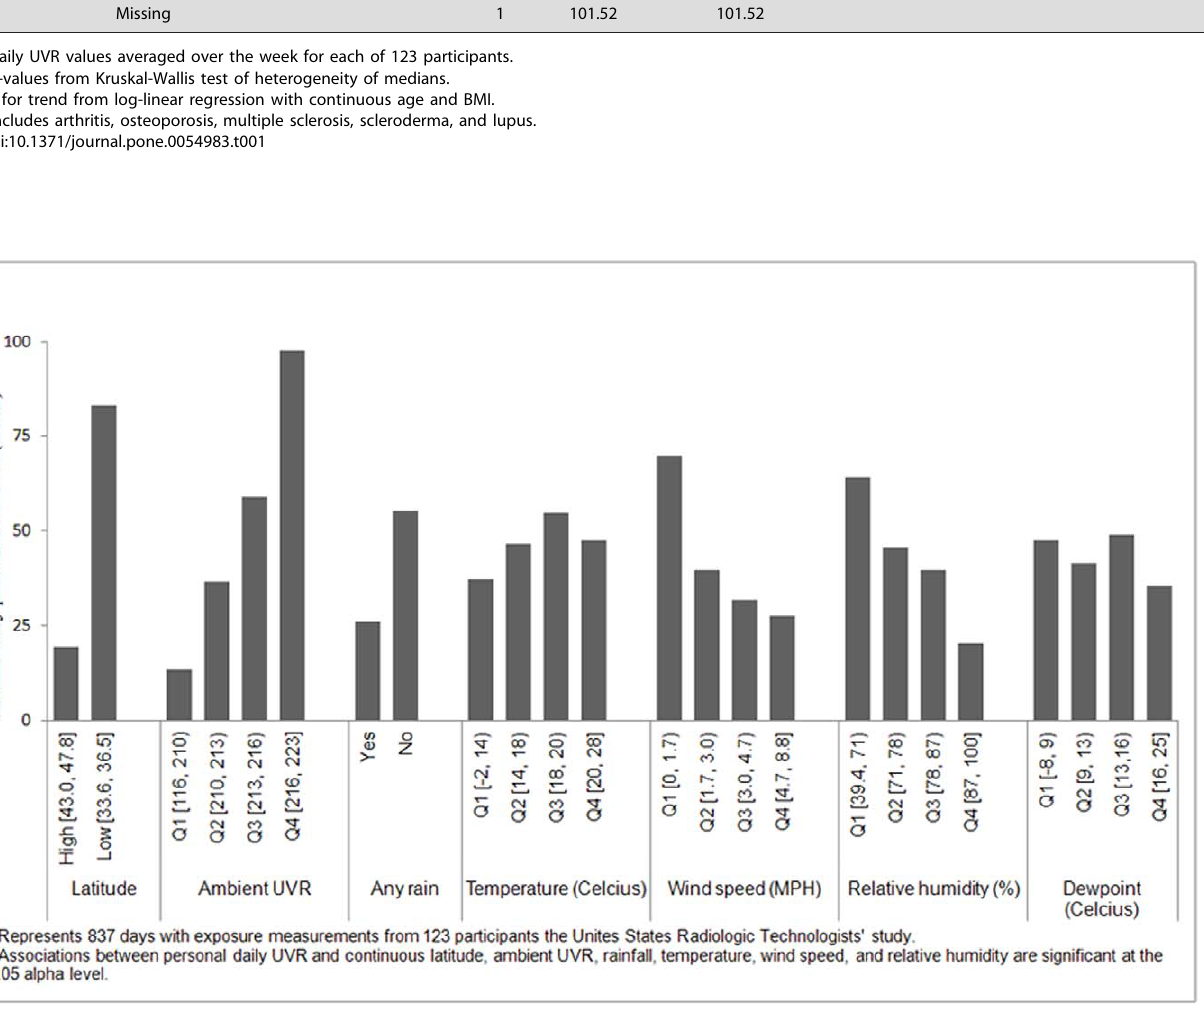
Figure 1. Distribution of personal UVR across environmental and meteorological factors. a Represents 837 days with exposure measurements from 123 participants the Unites States Radiologic Technologists’ study. b Associations between personal daily UVR and continuous latitude, ambient UVR, rainfall, temperature, wind speed, and relative humidity are significant at the 0.05 alpha level. doi:10.1371/journal.pone.0054983.g001 PLOS ONE |